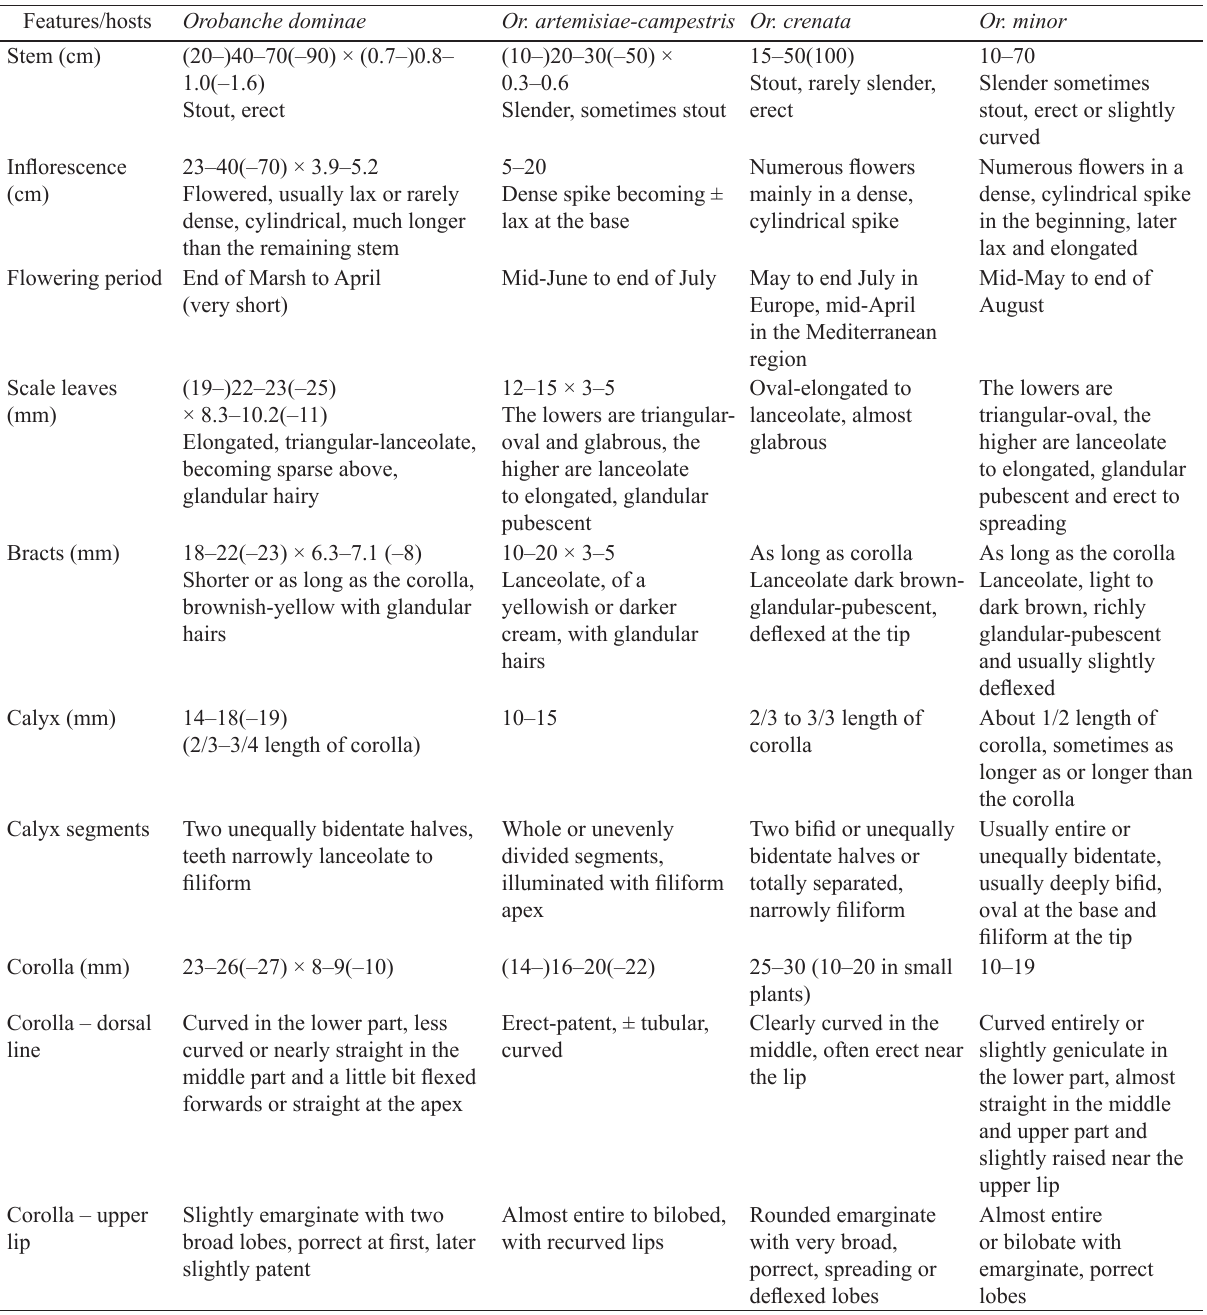
Table 1. Diagnostic characteristics, host and distribution of Orobanche dominae El Mokni sp. nov. and the most closely related species belonging to the subsections Minores Teryokhin and Speciosae Novopokr. Measurments of morphological features of the new species were analysed on 8 living mature plants whereas data presented for its closest relatives derived only from literature (e.g., Pottier-Alapetite, 1981; Rumsey & Jury, 1991; Kreutz, 1995; Foley, 2001; El Mokni et al. ,